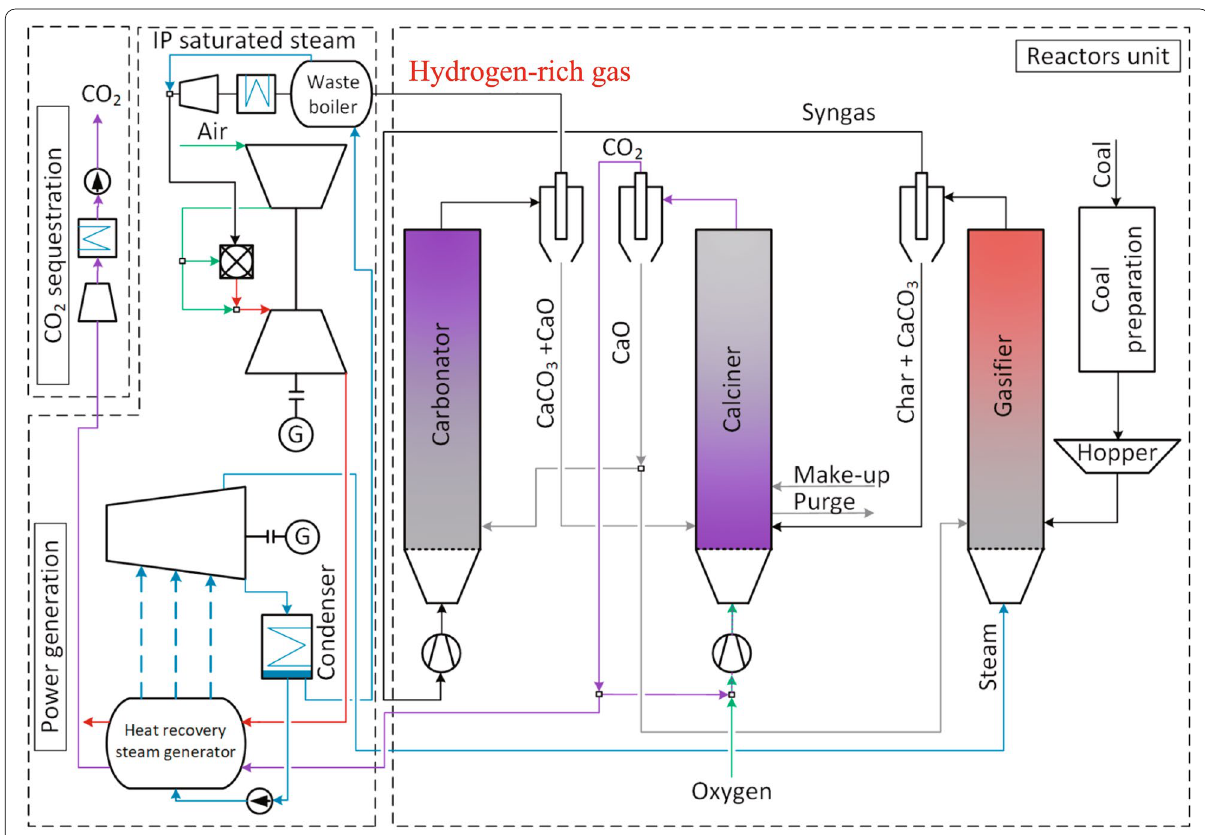
Fig. 21 Integration of calcium-looping with H 2 fuelled IGCC power plant